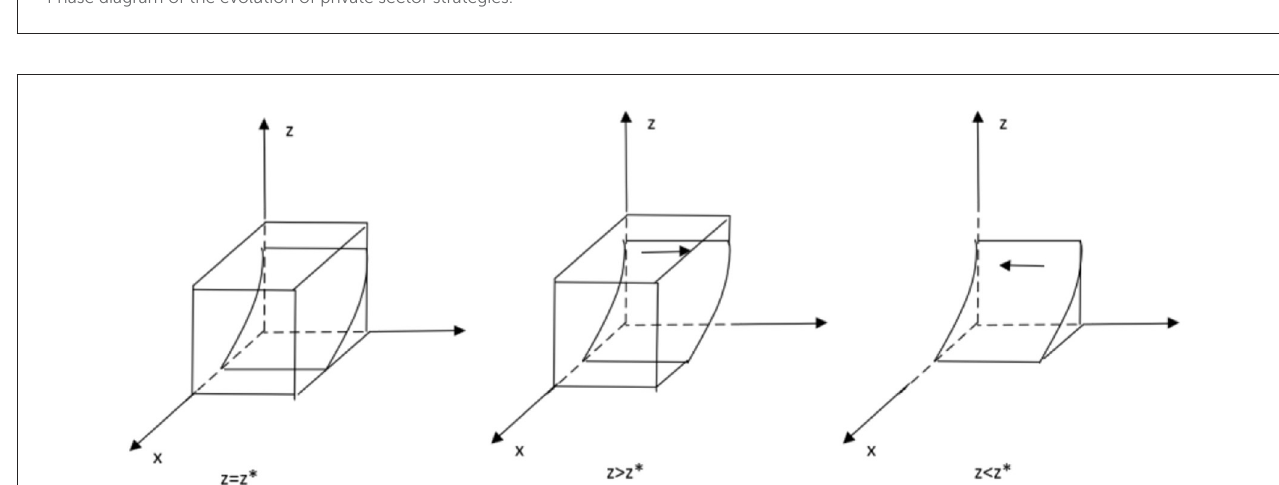
FIGURE2 Phase diagram of the evolution of government sector